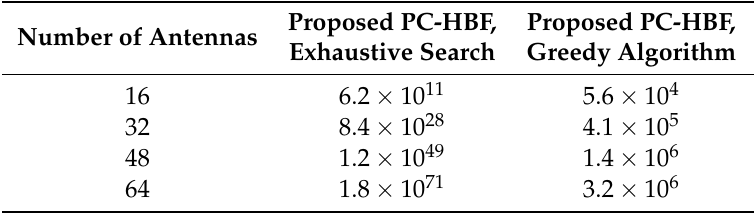
Figure 4. Energy efficiency comparison against number of users ( U = N RF ). N t = (64, 128, 256) and SNR = 20 dB. Table 1. Complexity